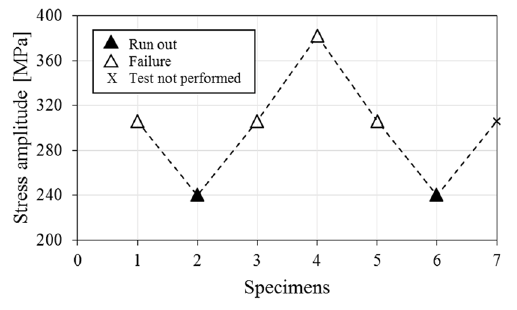
Figure 8. The staircase fatigue data. Therefore the fatigue strength of Inconel 625 was